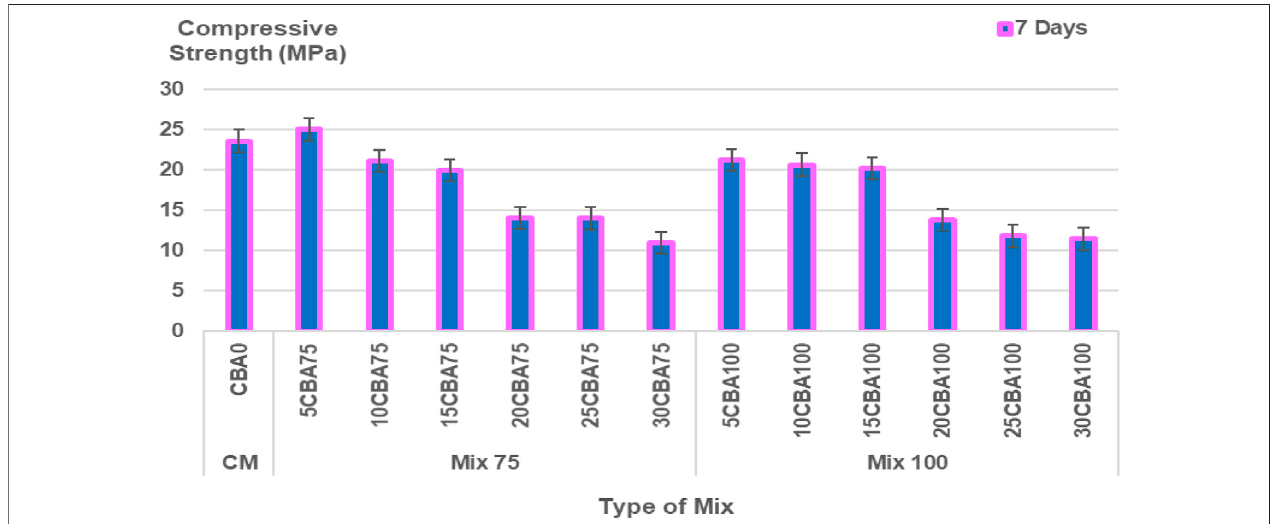
FIGURE 5 | Compressive strength (MPa) of Mix 75 and Mix 100 at 7 days.